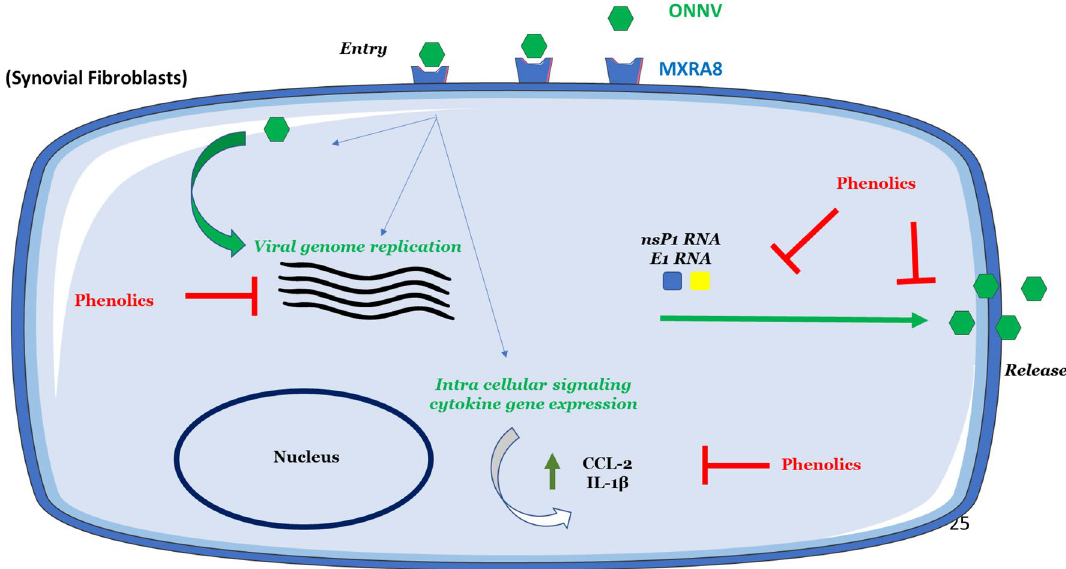
Figure 7. Antiviral mechanism of